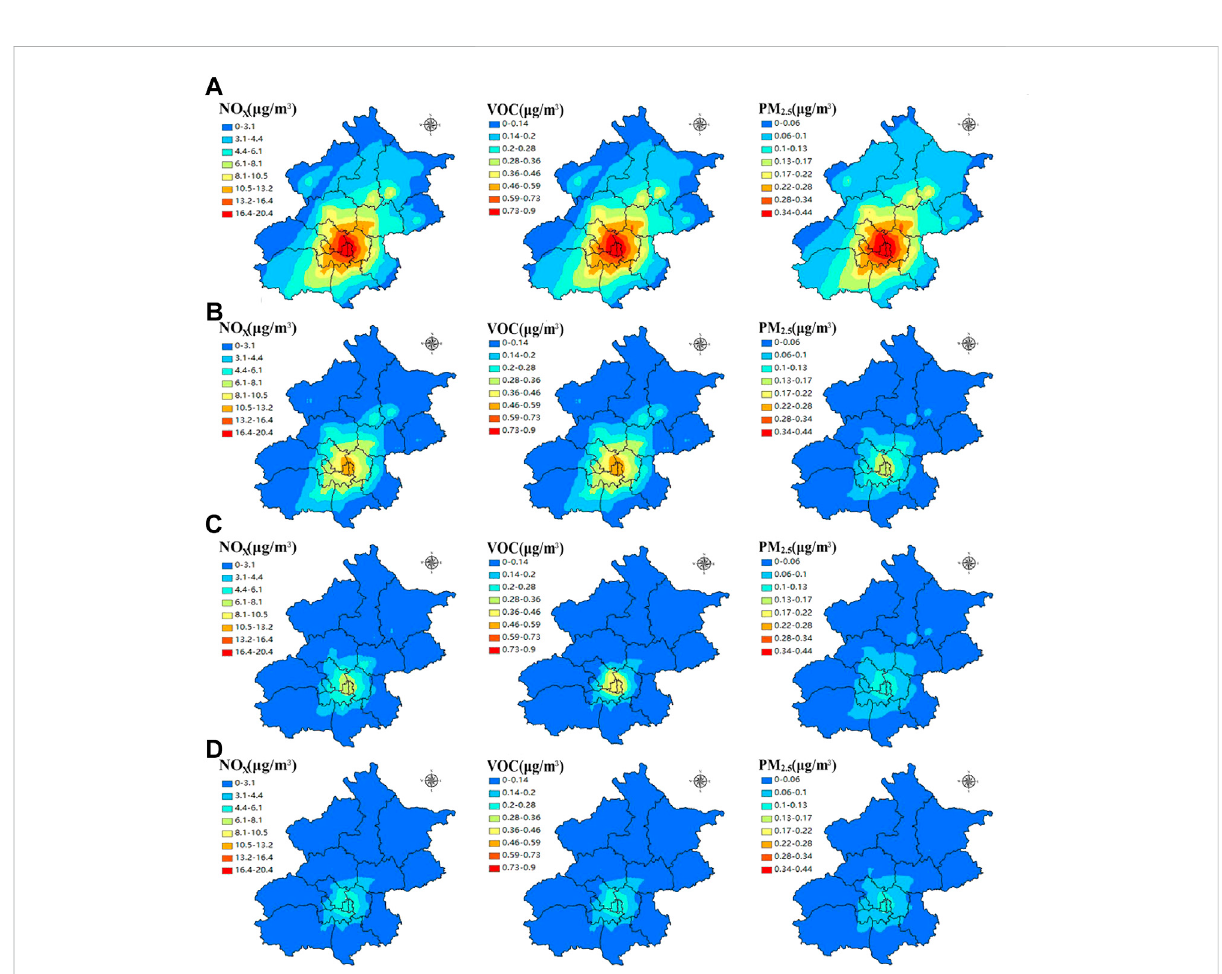
FIGURE 7 Impacts of diesel vehicles in Beijing in 2020 (A) and high- (B) , medium- (C) , and low-control scenarios (D) in 2035 on air